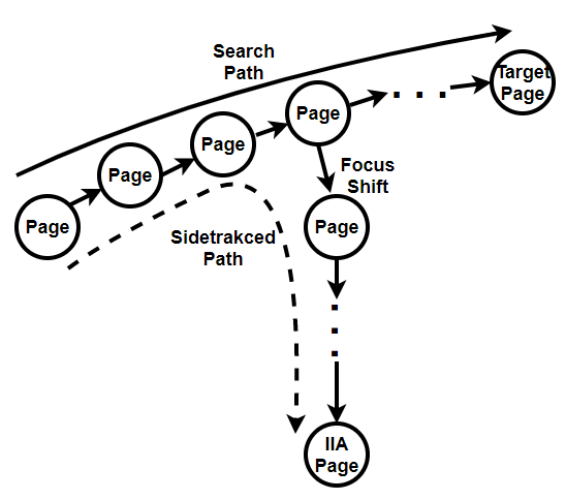
Figure 3. An illustration of pre-encountering calculation process with simple